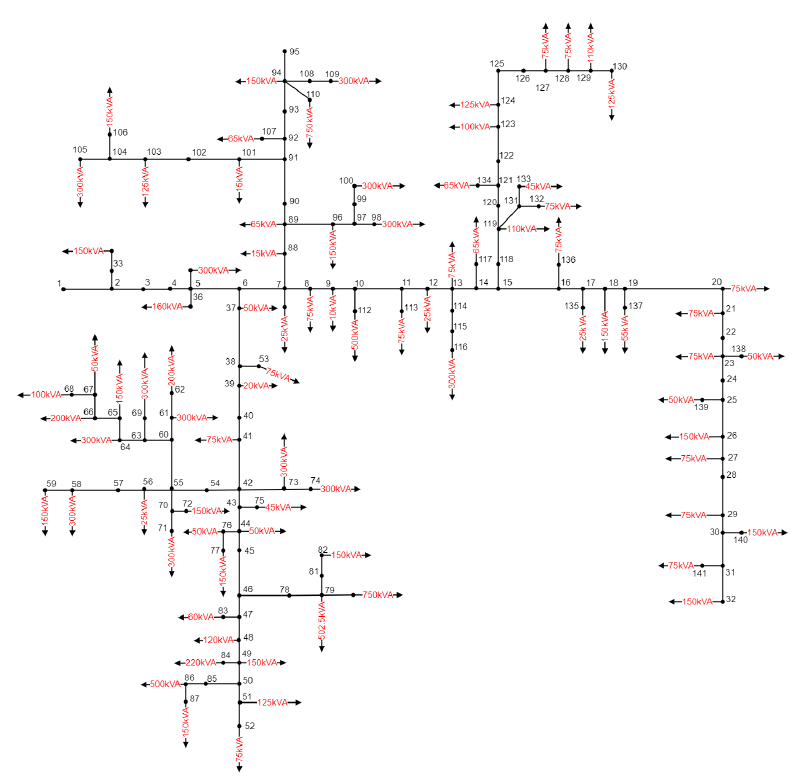
Figure 10. Single-line diagram of the 141-bus test system.